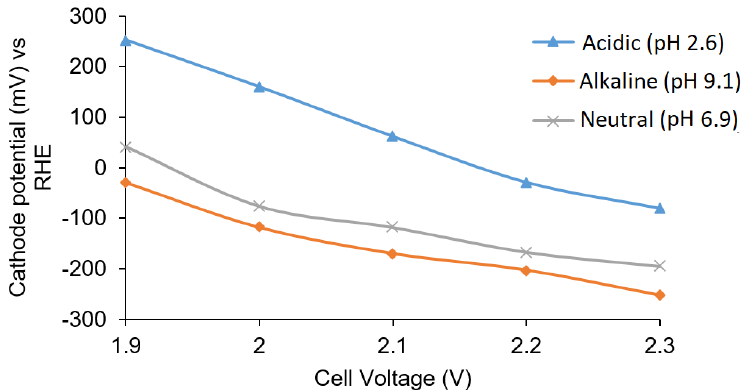
Figure 4. Cell voltage and resulting cathode potential (vs. reversible hydrogen electrode (RHE)) in different buffer solutions.